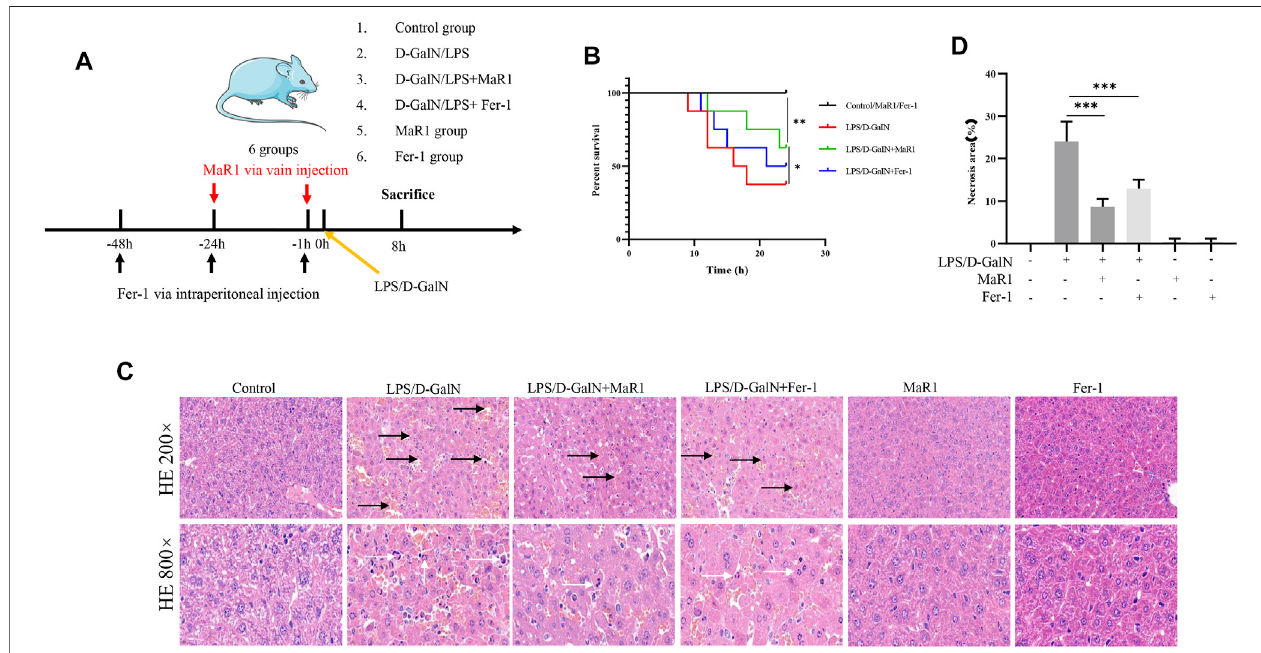
FIGURE 1 | MaR1 and Fer-1 mitigated D-GalN/LPS-induced liver injury. (A) The treatments of mice. (B) The administration of MaR1 and Fer-1 signi fi cantly improved the median survival in mice treated with D-GalN/LPS. (C,D) The HE staining of liver tissue showed that D-GalN/LPS induced signi fi cant liver injury, while the administration of MaR1 and Fer-1 signi fi cantly mitigated D-GalN/LPS-induced liver injury. Black arrow showed necrotic tissue, and white arrow showed in fl ammatory cells. Data are shown as the mean ± SD, * p < 0.05; ** p < 0.01; *** p < 0.001.